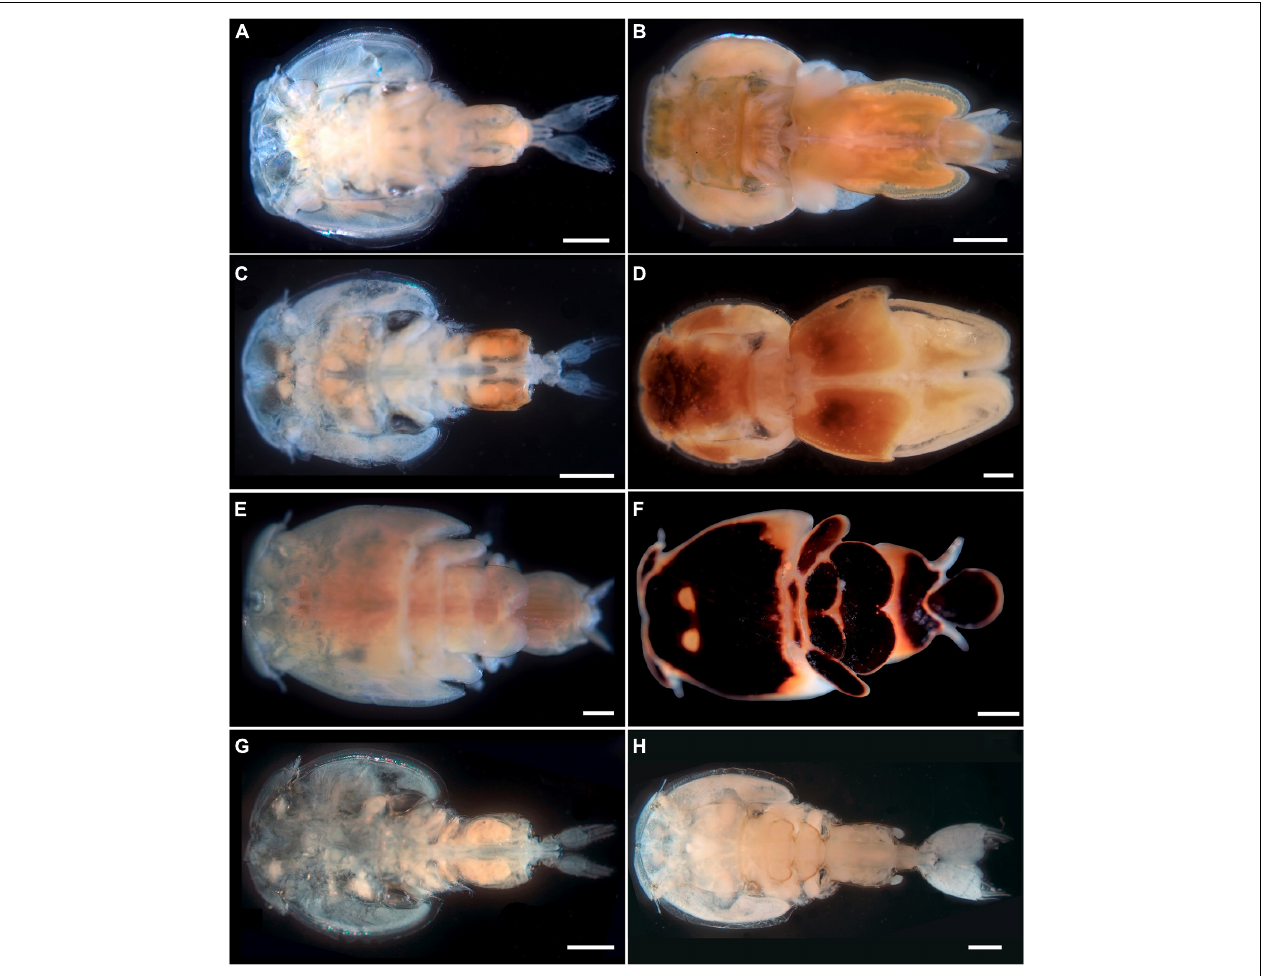
FIGURE 1 | Specimens of pandarid copepods sequenced in the present study. Dinemoura latifolia dorsal view of male (A) (bar scale: 1,000 µ m) and female (GenBank: OL415938 and MZ935643) (B) (bar scale: 2,000 µ m) from the great white shark; Echtrogaleus coleoptratus dorsal view of male (C) (bar scale: 1,000 µ m) and female (GenBank: OL348230 and MZ935645) (D) (bar scale: 1,000 µ m) from the blue shark; Pandarus satyrus dorsal view of male (E) (bar scale: 500 µ m) and female (GenBank: OL457303 and OL333876) (F) (bar scale: 1,000 µ m) from the blue shark; Phyllothyreus cornutus dorsal view of male (G) (bar scale: 1,000 µ m) and female (GenBank: MZ935644) (H) (bar scale: 2,000 µ m) from the blue